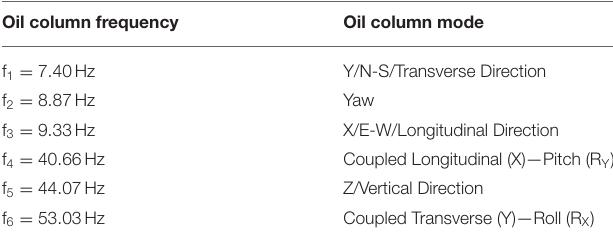
TABLE 5 | Prediction of oil column frequencies and modes for the LHPOST6 (bare